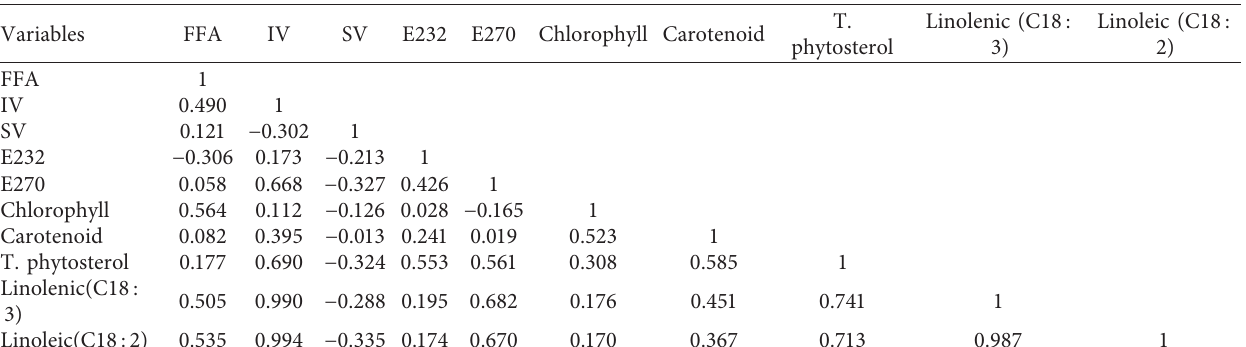
Table 6: p values of the correlation matrix coefficient between all variables.